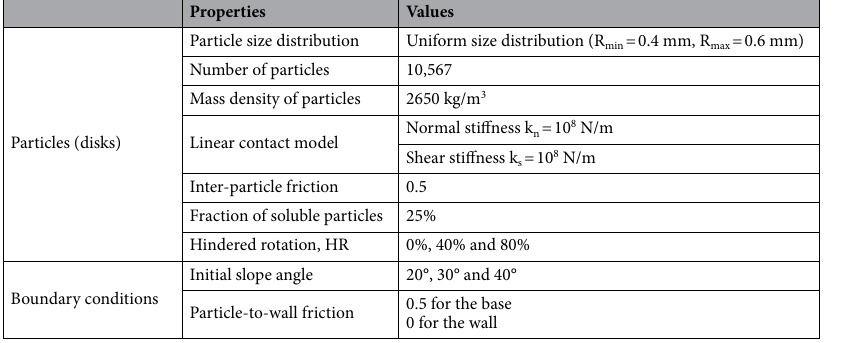
Table 1. Two-dimensional discrete element simulation